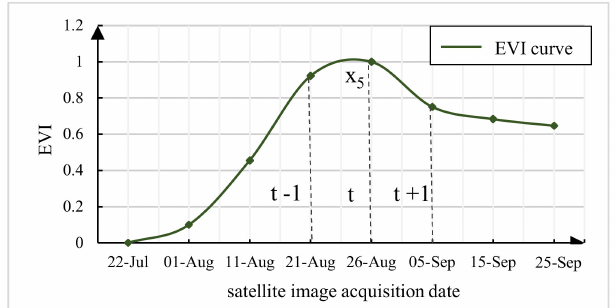
Figure 3. Schematic illustration of the variation of spectral index (VSI) (for example VSI_EVI) calculation. Each point represents the silage maize EVI calculated based on the average of all pixel values in the silage maize class for Sentinel-2 multi-temporal data. t is a specific date at x 5 that intercepts the fifth value of EVI in this figure, t − 1 and t + 1 are the values preceding and following the specific